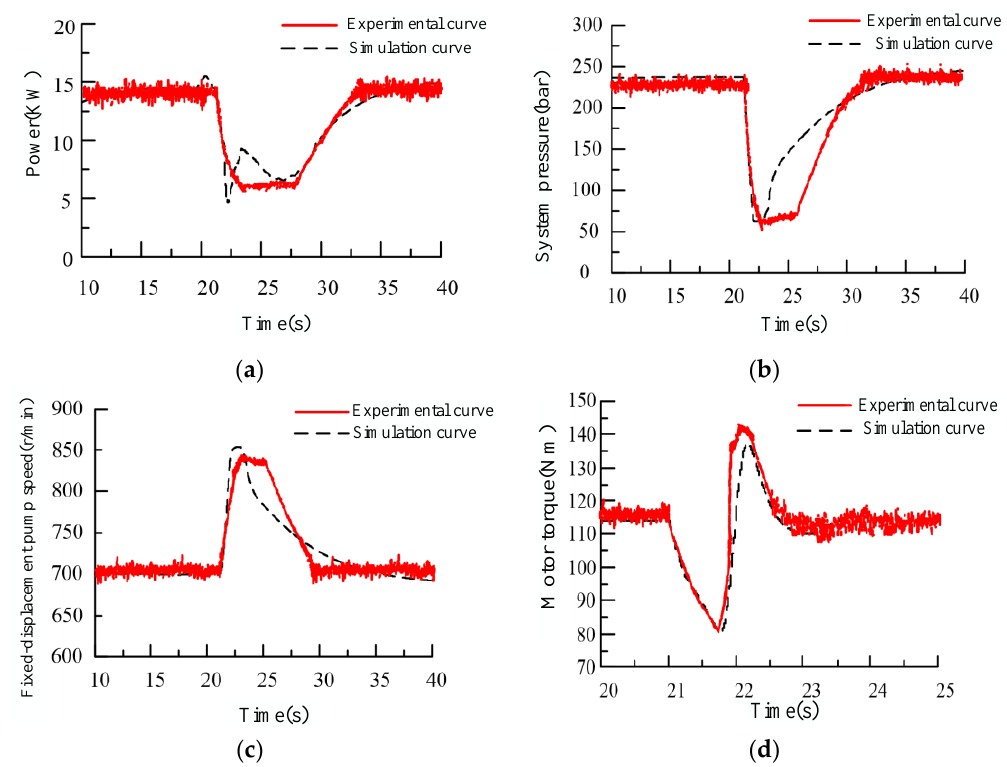
Figure 15. Curve for grid voltage single-phase drop of 80%. ( a ) Output power test curve; ( b ) System pressure test curve; ( c ) Fixed-displacement pump speed test curve; ( d ) Motor torque test curve.